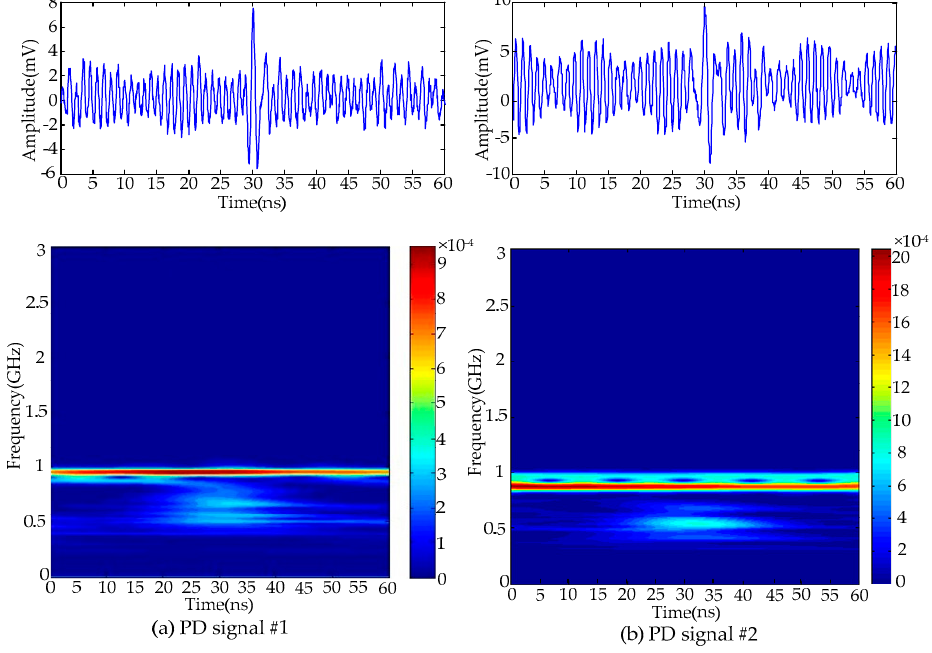
Figure 15. Waveforms and time-frequency distributions detected UHF PD signals: ( a ) signal #1; ( b ) signal #2.